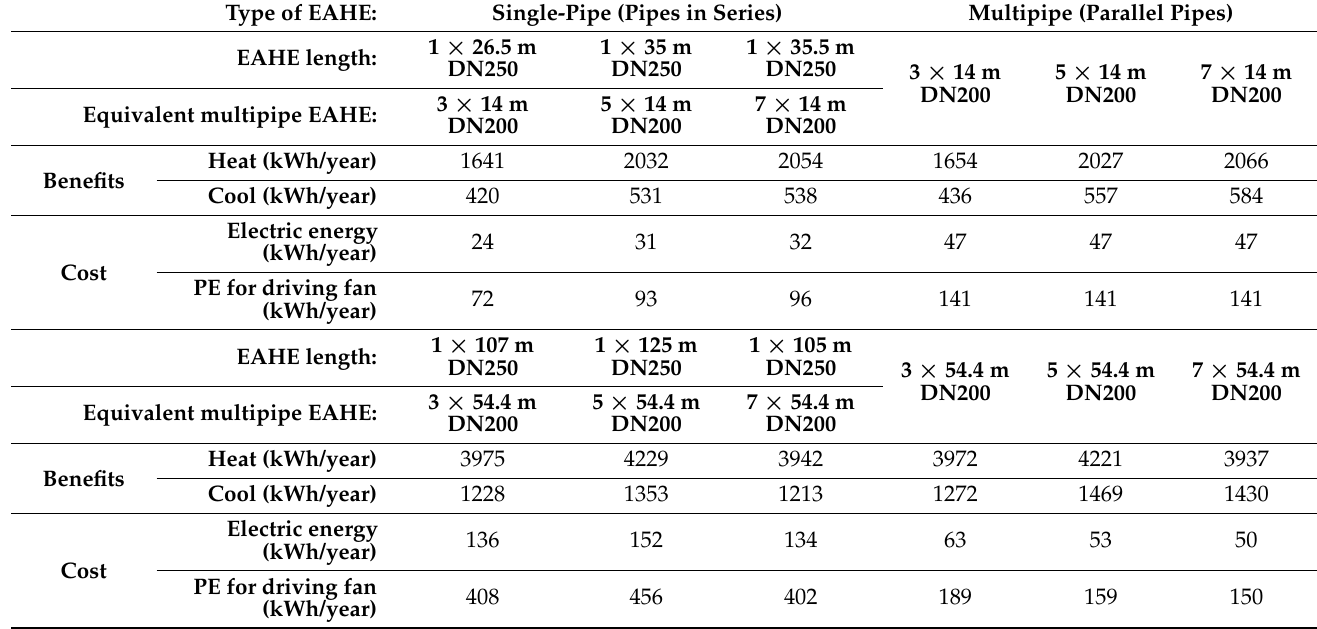
Table 8. Equivalent length of DN250 single-pipe EAHE replacing a given multipipe exchanger in terms of heat; the results of calculations of annual electricity consumption and primary energy consumption for fan drive, V = 600 m 3